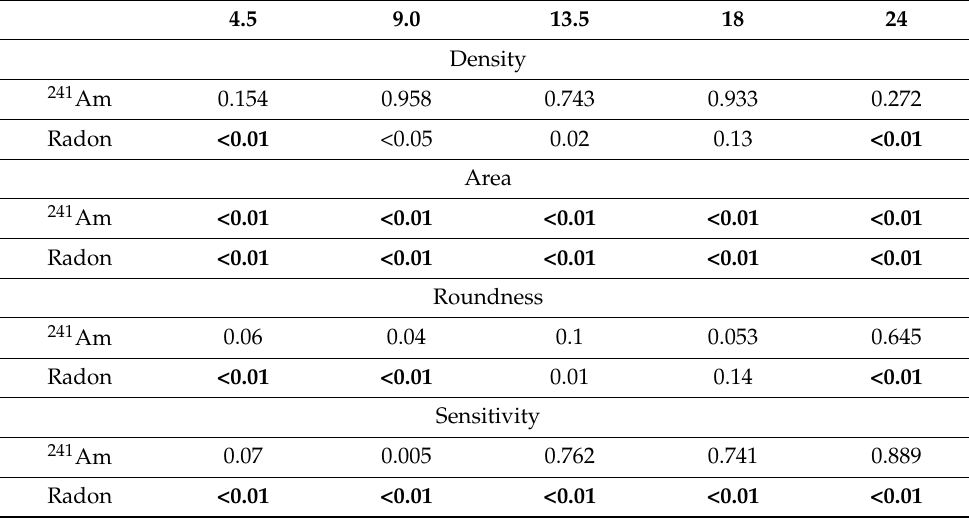
Table 12. One-way ANOVA for pre-etching effect with fixed etching time.